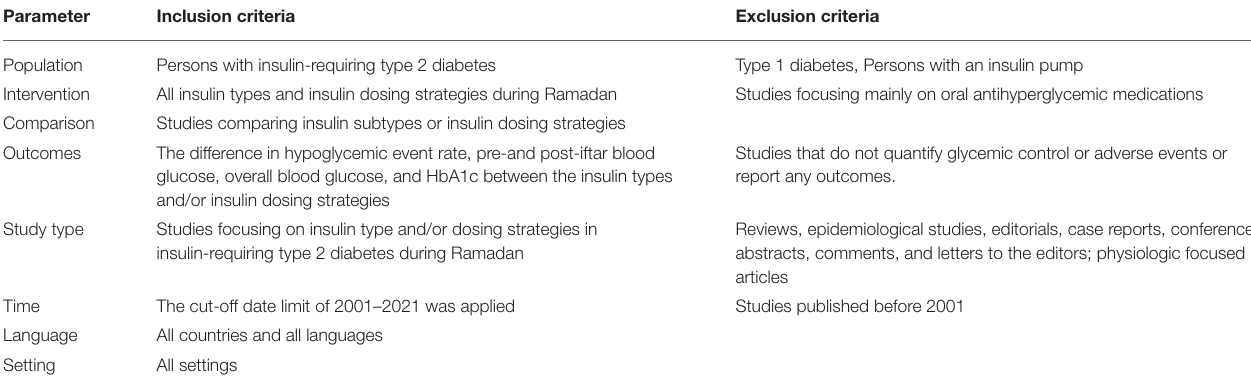
TABLE 1 | PICOS criteria applied for the systematic